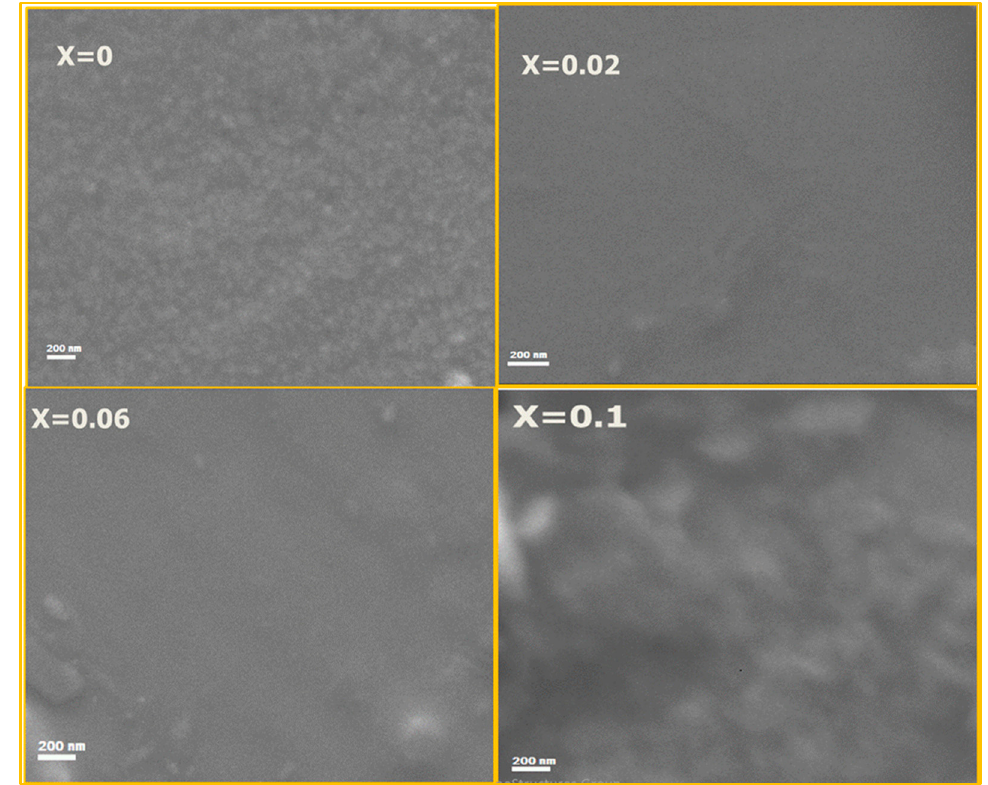
Figure 3. SEM images of x = 0.00, 0.02, 0.04 and 0.1 of Cr doped Co 3 O 4 thin films.